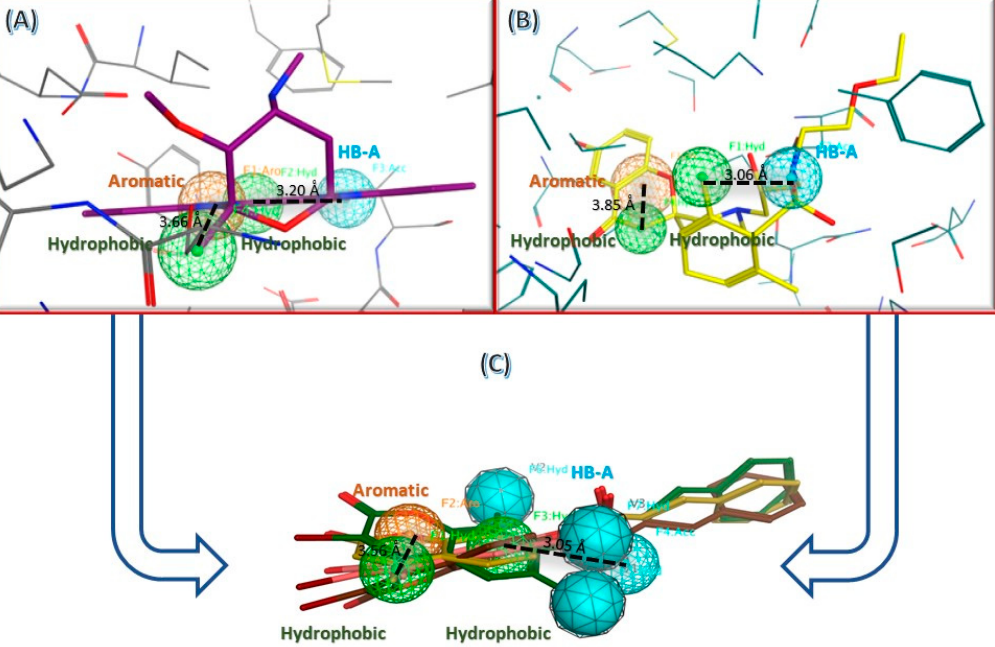
Figure 12. Common pharmacophoric features of the ( A ) staurosporine inhibitor (violet) of PI3K, ( B ) spirochromane inhibitor (yellow) of AKT1, and ( C ) superimposed structures of the proposed final compounds; hydrophobic features are represented as green contour spheres; aromatic features are represented as orange contour spheres, and HB_A features are represented as turquoise contour spheres. Additional HB_A features in the proposed compounds are represented as turquoise solid spheres.